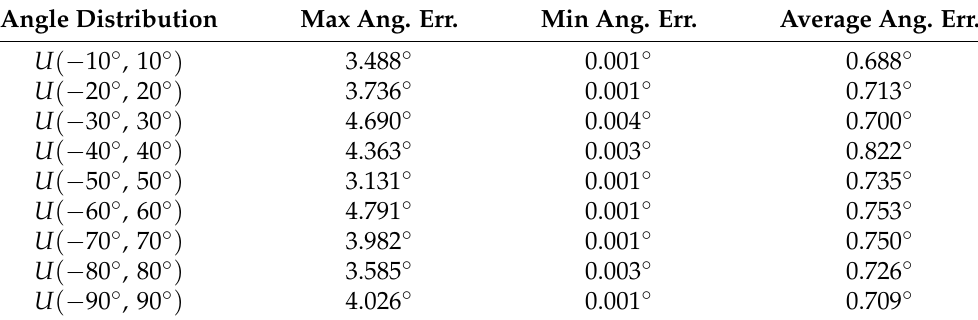
Figure 9. Qualitative results of orientation alignment. Regardless of how much the image angle shifted, the orientation alignment module adjusts it correctly. Table 1. The quantitative results for the orientation alignment module. The evaluation metric is the angle error.